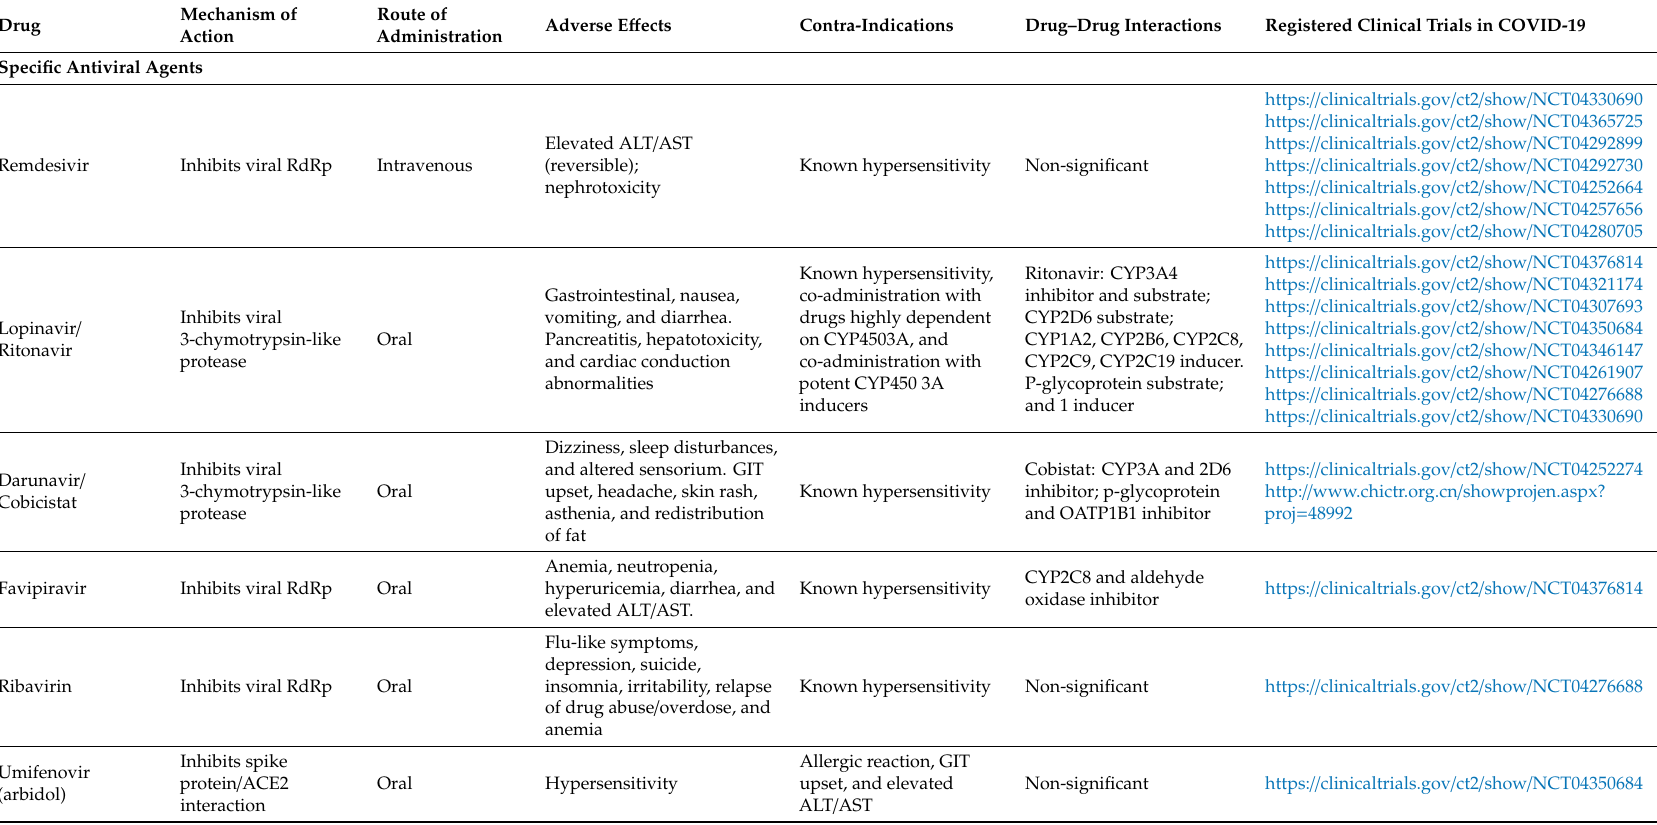
Table 1. Pharmacology of coronavirus disease (COVID-19) therapies under clinical